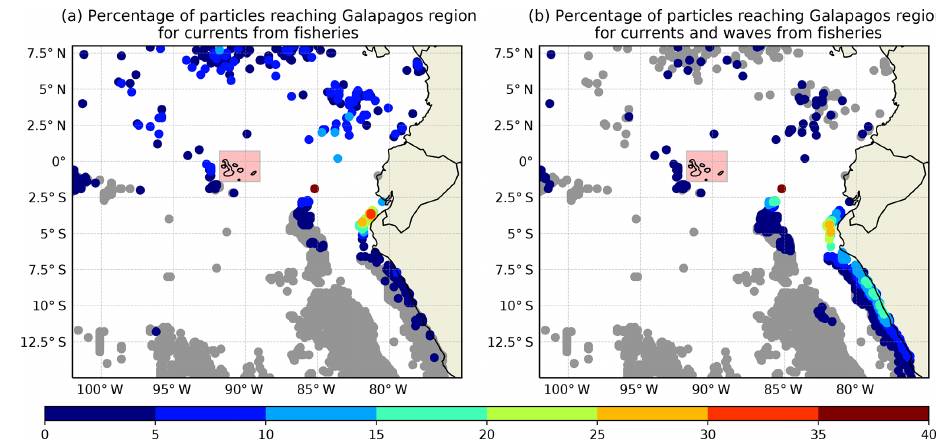
Figure 8. Maps from the “Fate from regional fisheries” scenario, showing the percentage of particles that reach the Galápagos region (red box) from each of the 3885 locations where at least 24h of fishing was reported in the Global Fishing Watch dataset (Kroodsma et al., 2018). Panel (a) shows percentages for the currents-only simulation and (b) the percentages for the currents + wave simulation. Floating particles from most of these locations have a zero probability of ending up near the Galápagos within 5 years (grey circles), but there are extensive regions of non-zero probabilities (coloured circles) near the Peruvian and Ecuadorian